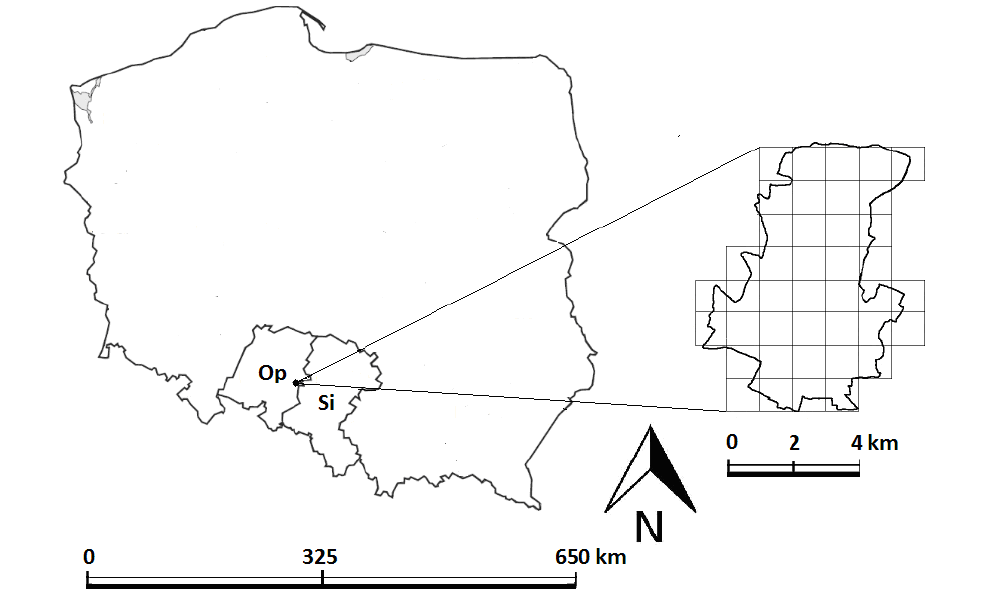
Fig. 1. Map of Strzelce Opolskie , situated in Opole voivodeship (Southern Poland) showing the 1-km grid and the city borders (Op – Opole voivodeship, Si – Silesian